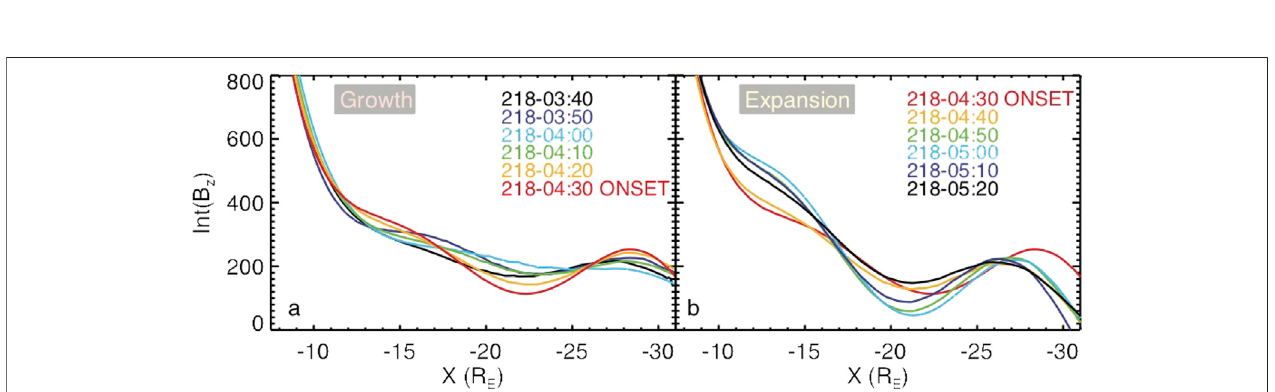
FIGURE8| TwoX-lines, X n and X m resolvedintheequatorialdistributionofthemagnetic fi eld B z (using0-degreetiltangle)asearthwardpartsofthecontours B z for the 6 August 2017 substorm. The format of this fi gure is similar to that of Figures 1B , 2 . However, in contrast to Figure 2 , the projections ofthe spacecraft coordinates on the equatorial plane are now shown by colored dots. The color of the j th dot re fl ects the distance R ( j ) q of the corresponding NN from the query point log w